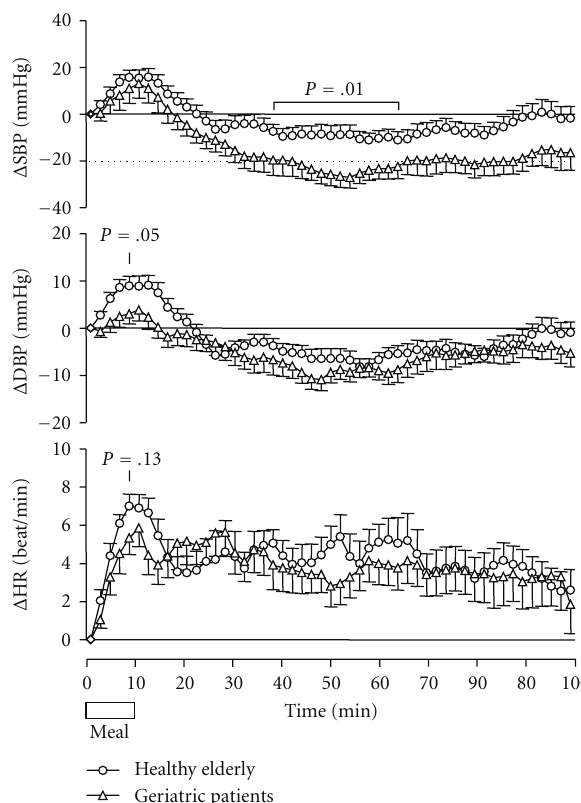
Figure 1: Mean change in systolic blood pressure (SBP), diastolic blood pressure (DBP), and heart rate (HR) in 22 geriatric patients and 20 healthy elderly individuals during and after breakfast ( P - values of di ff erences between